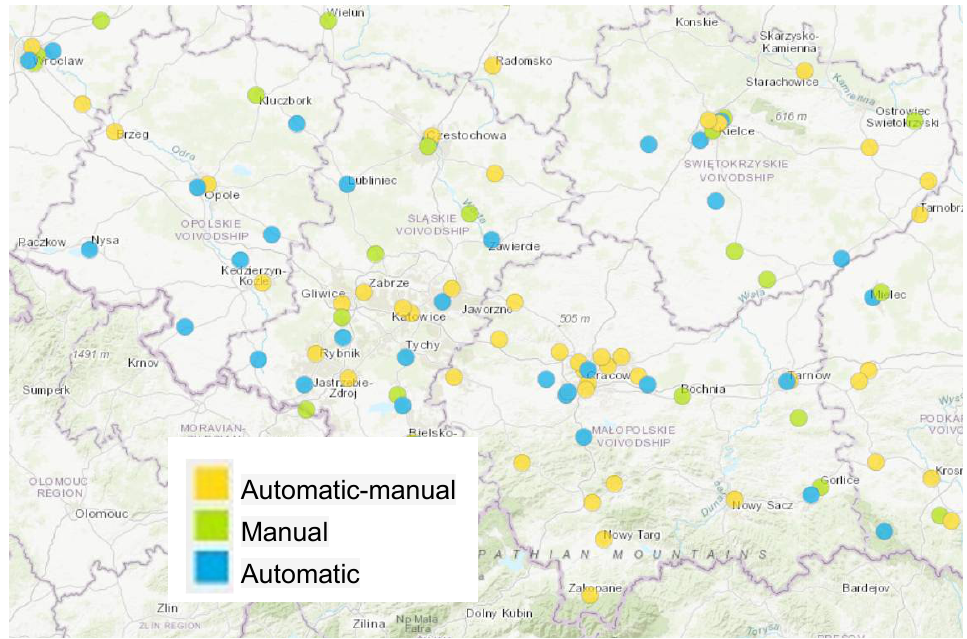
Figure 2. Location of air quality measuring stations in Southern Poland [50].